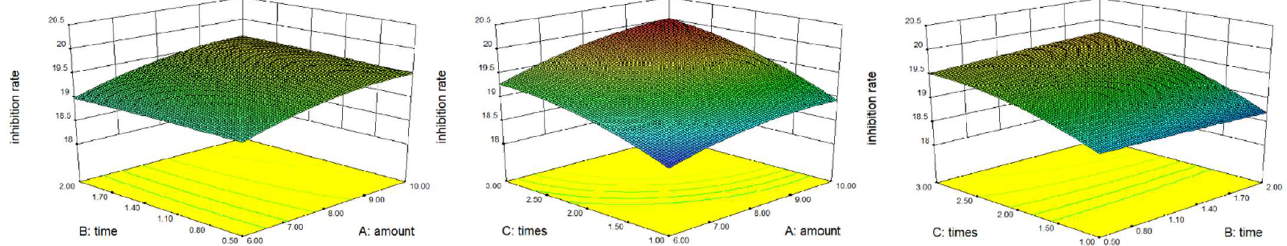
Figure 2. The 3D response surface diagram of dependent variables against independent variables.